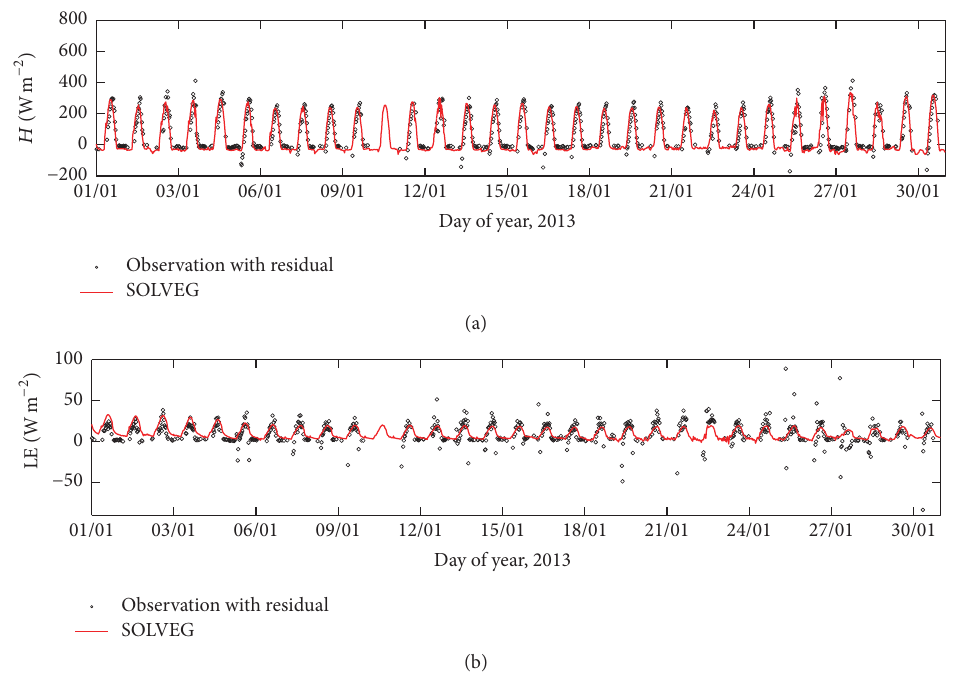
Figure 3: Temporal changes in (a) sensible heat flux and (b) latent heat flux, after the residual energy corrections during the dry period.